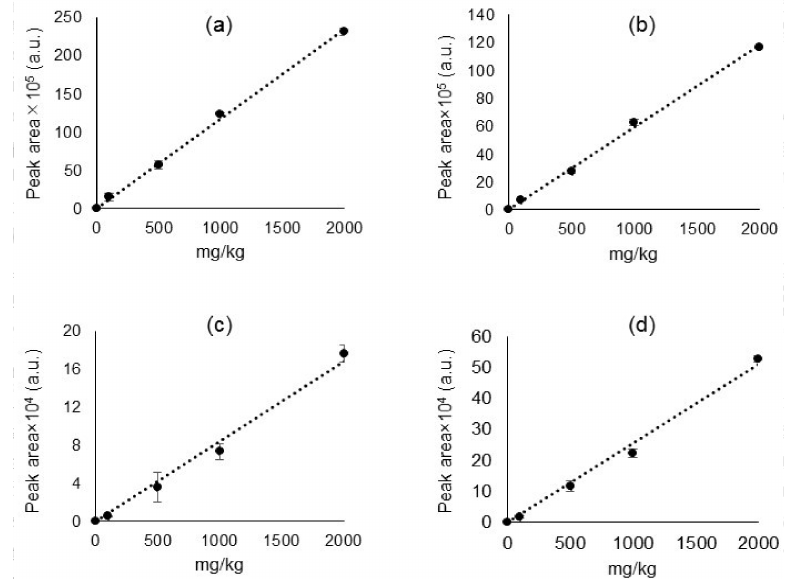
Figure 5. Calibration curves of ( a ) DEHP ( m / z 279); ( b ) SCCPs ( m / z 89); ( c ) HBCDD ( m / z 319), and ( d ) DecaBDE ( m / z 799), each 5-point calibration by 0, 100, 500, 1000, and 2000 mg/kg. Error bars represent the average of three repeated